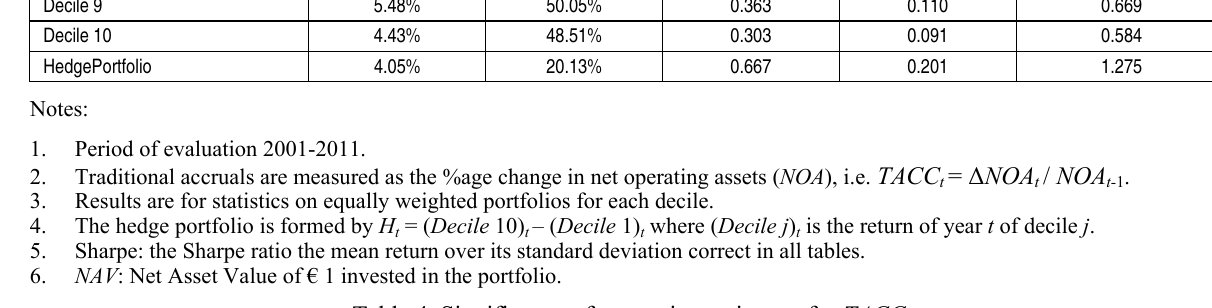
Table 4. Significance of regression estimates for